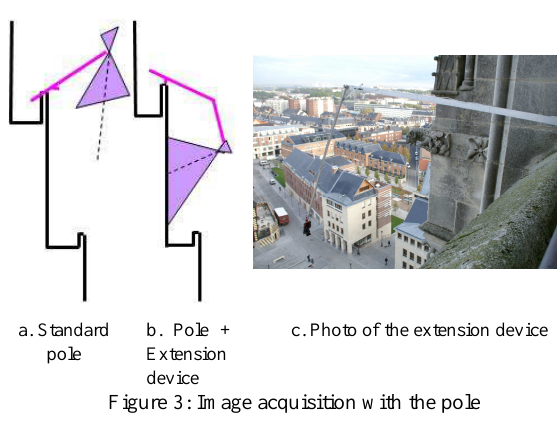
Figure 3: Image acquisition with the